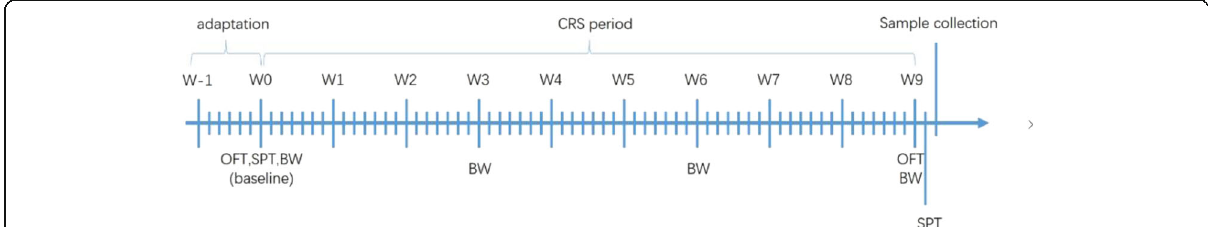
Fig. 1 Schedule of the procedures used in the present study. The tests included the open-field test (OFT) and sucrose preference test (SPT). CRS, chronic restraint stress; BW, body